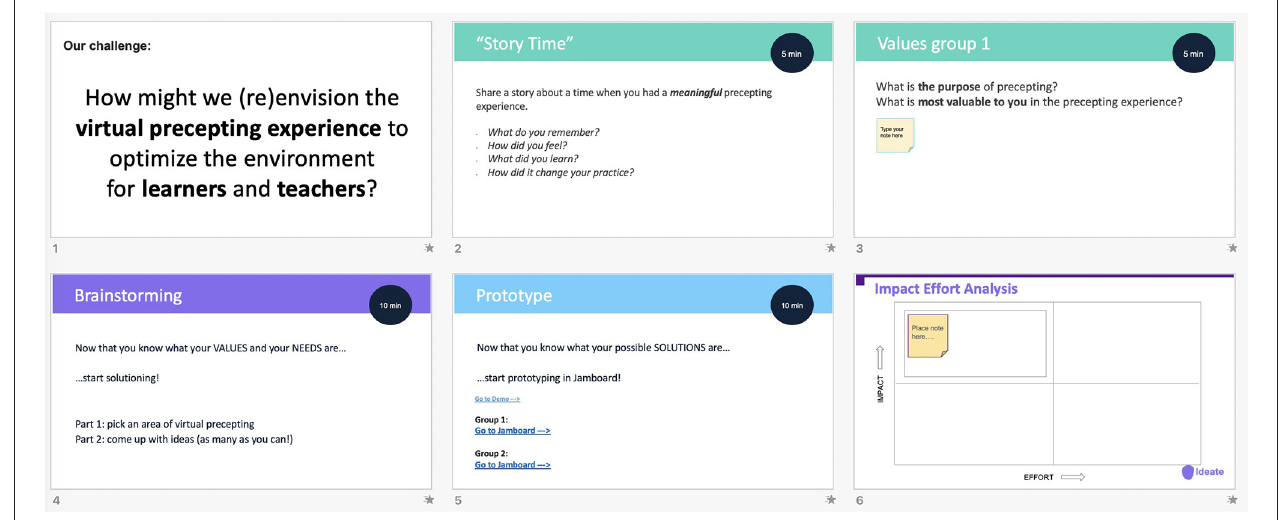
FIGURE 2 | The Design Thinking Workshop.